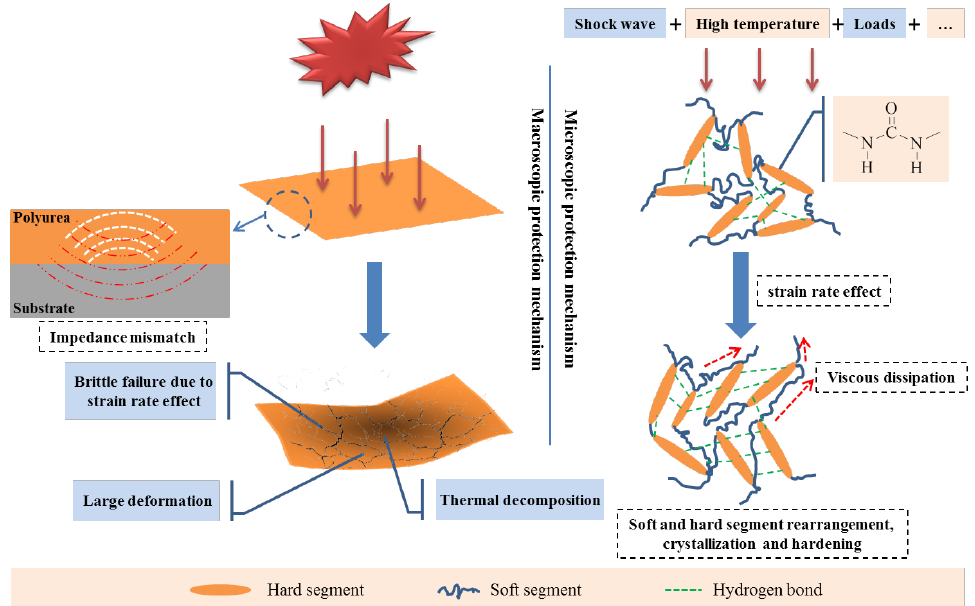
Scheme 2. Schematic illustration of the protection mechanisms of polyurea